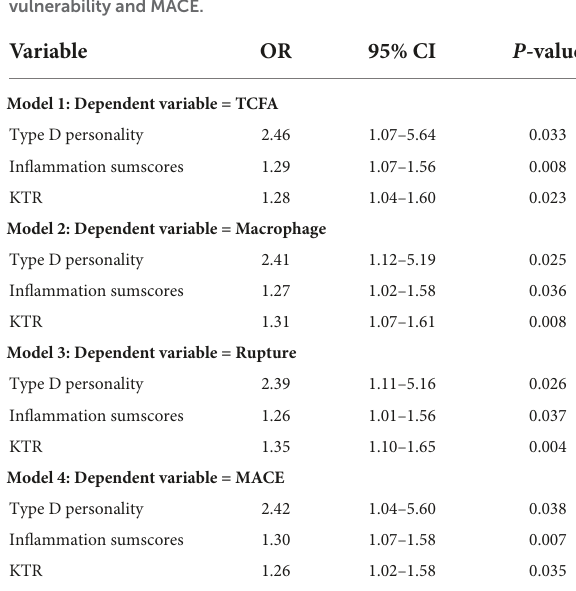
TABLE 3 Multivariate regression model for coronary plaque vulnerability and